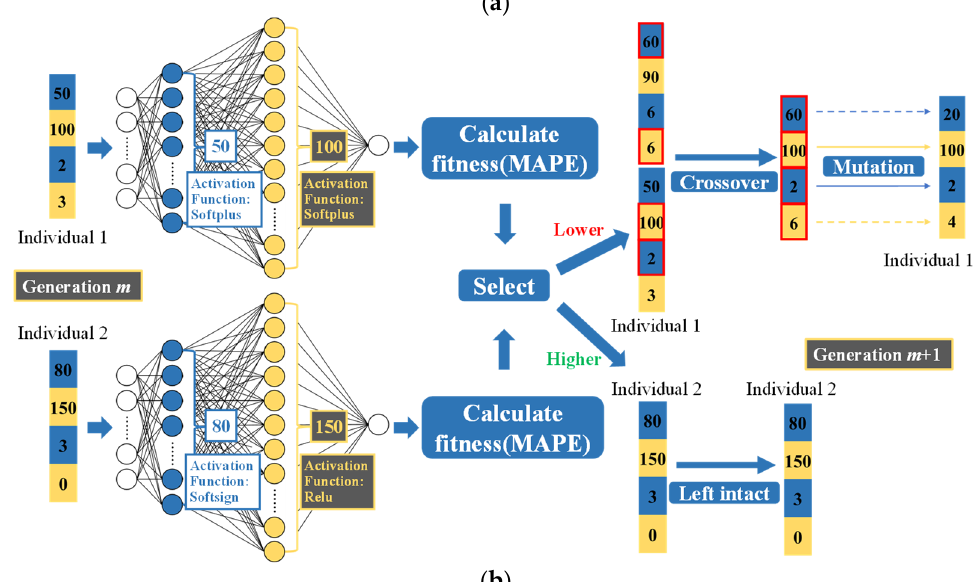
Figure 3. Schematic diagram of GA for the finding the ANN structure with the best modeling performance: ( a ) individual structure and ( b ) GA evolution procedure.